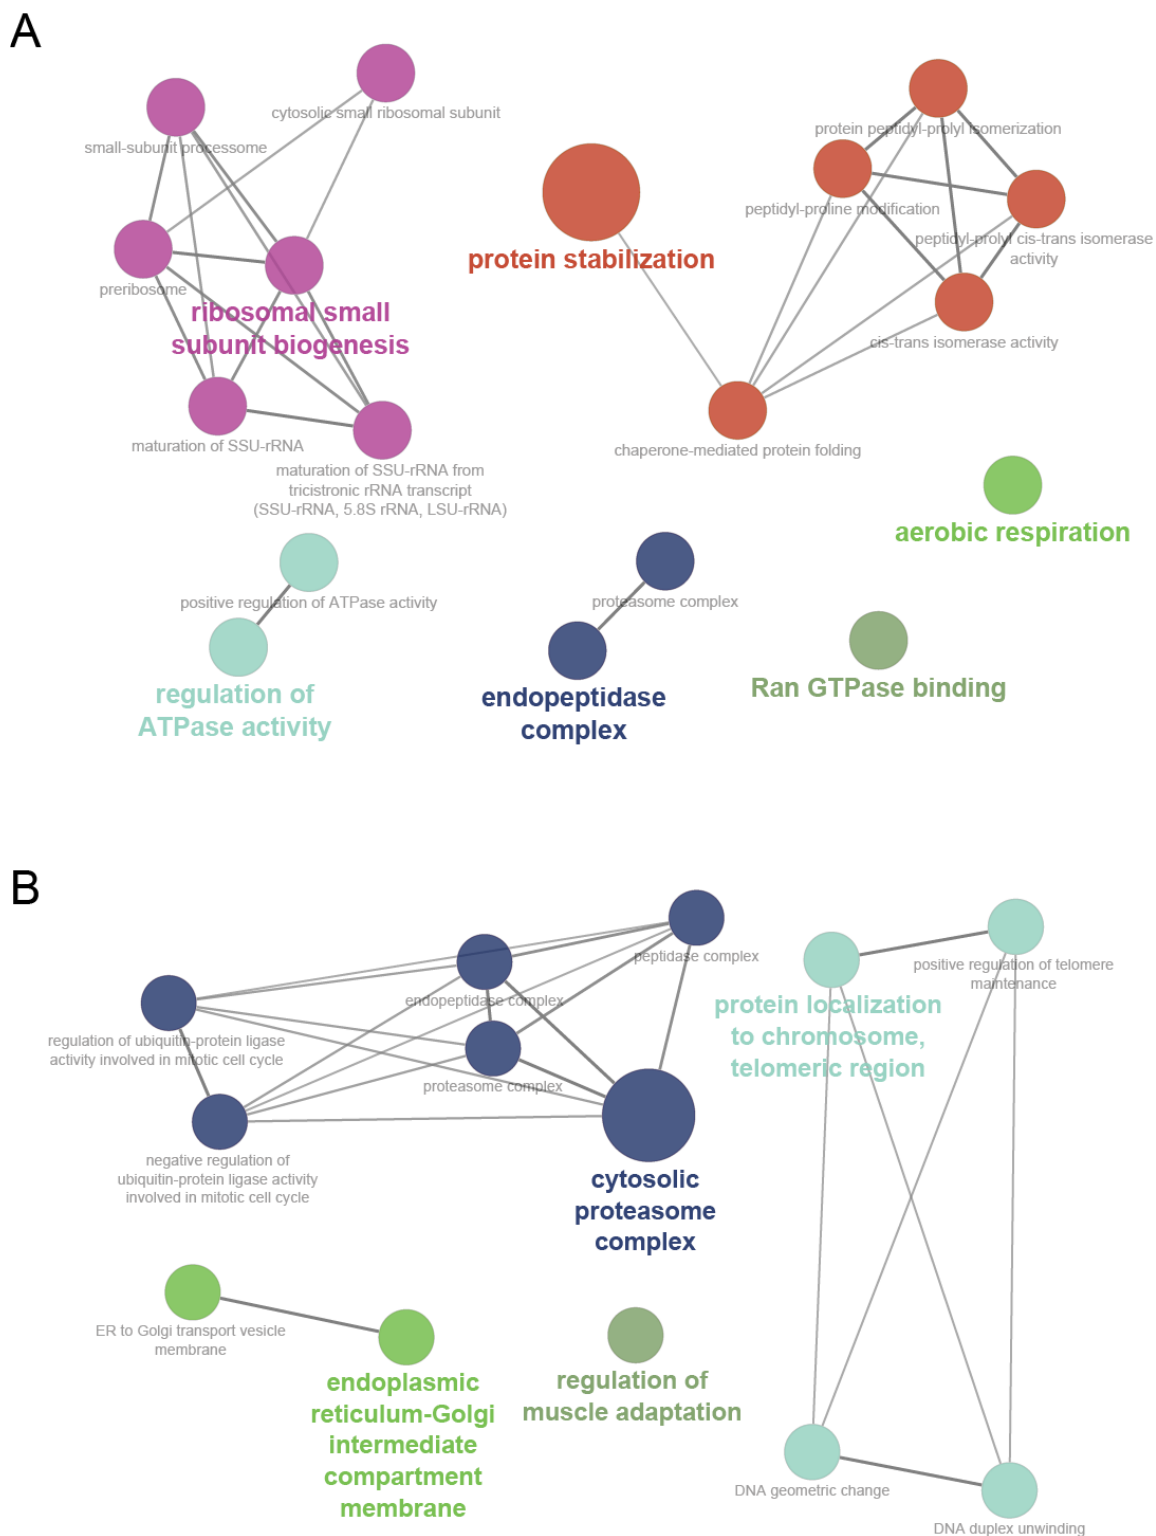
Figure 5. The gene annotation enrichment analysis results for the ‘ biological process and molecular function ’ GO categories for the cyan ( A ) and magenta ( B ) modules. A functionally grouped network is shown. The terms are represented as nodes that are linked based on the terms ’ kappa scores levels (≥0.4).